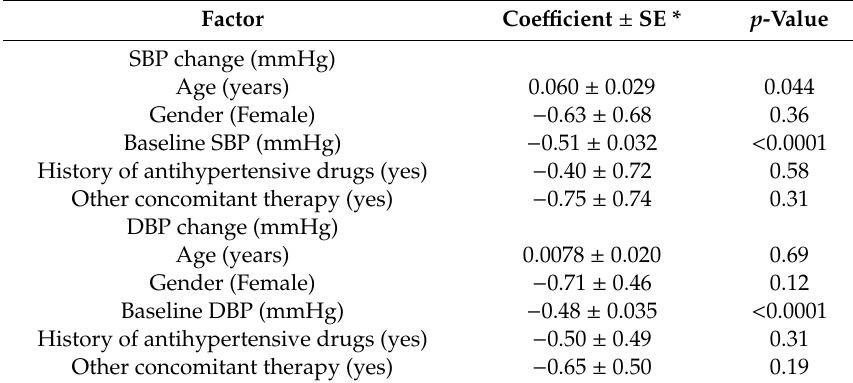
Table 4. Baseline factors associated with systolic blood pressure (SBP) and diastolic blood pressure (DBP) changes after 2-month supplementation with Tensiofytol ®